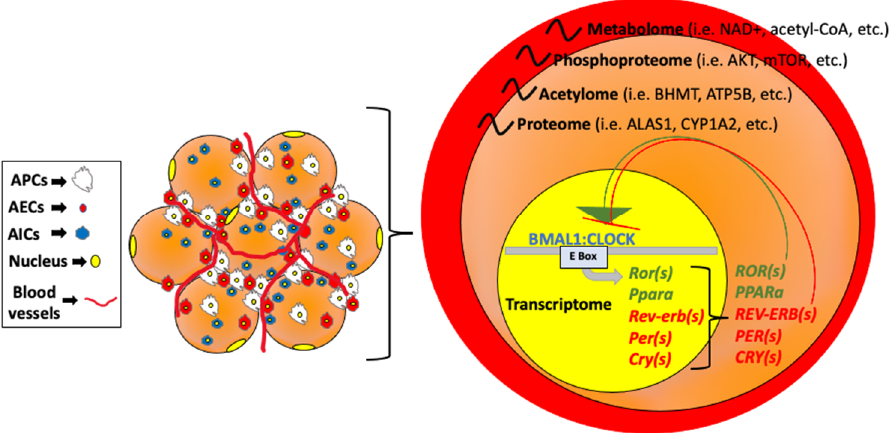
Figure 1. Circadian regulatory factors in cells of the body. Left: Adipose tissue, which is comprised of adipocyte progenitor cells (APCs), endothelial cells (AECs), and immune cells (AICs) contains the same clock regulatory factors important for rhythmicity in other cell types. Right: The PAS-domain containing transcription factors CLOCK and BMAL1 heterodimerize to form a complex that binds to and generally activates target genes harboring E box consensus sites in the promoter. Target genes include the negative regulators of the complex, including the PER and Cry genes, which when rhythmically expressed, directly interact with the CLOCK:BMAL1 heterodimer and block subsequent transactivation of target genes. Rev-erbα and Rev-erbβ can transcriptionally repress BMAL1 expression, while Rorα and Pparα can transcriptionally activate BMAL1. This transcriptional feedback loop regulates the rhythmicity of hundreds of genes involved in metabolism (resulting in rhythmic metabolite production [2] among other rhythmic cellular processes). However, post-transcriptional and post-translational modifications are also highly dynamic throughout the 24-h cycle. These modifications include acetylation and phosphorylation of proteins within the cell [4,5]. These target genes include the regulation of their own negative regulators, the PERiod ( PER ) and CRYptochrome ( CRY ) genes, as well as the nuclear receptor subfamily 1, group D (Nr1d1), also known as reverse erythroblastosis virus alpha (Rev-erb α ). On the